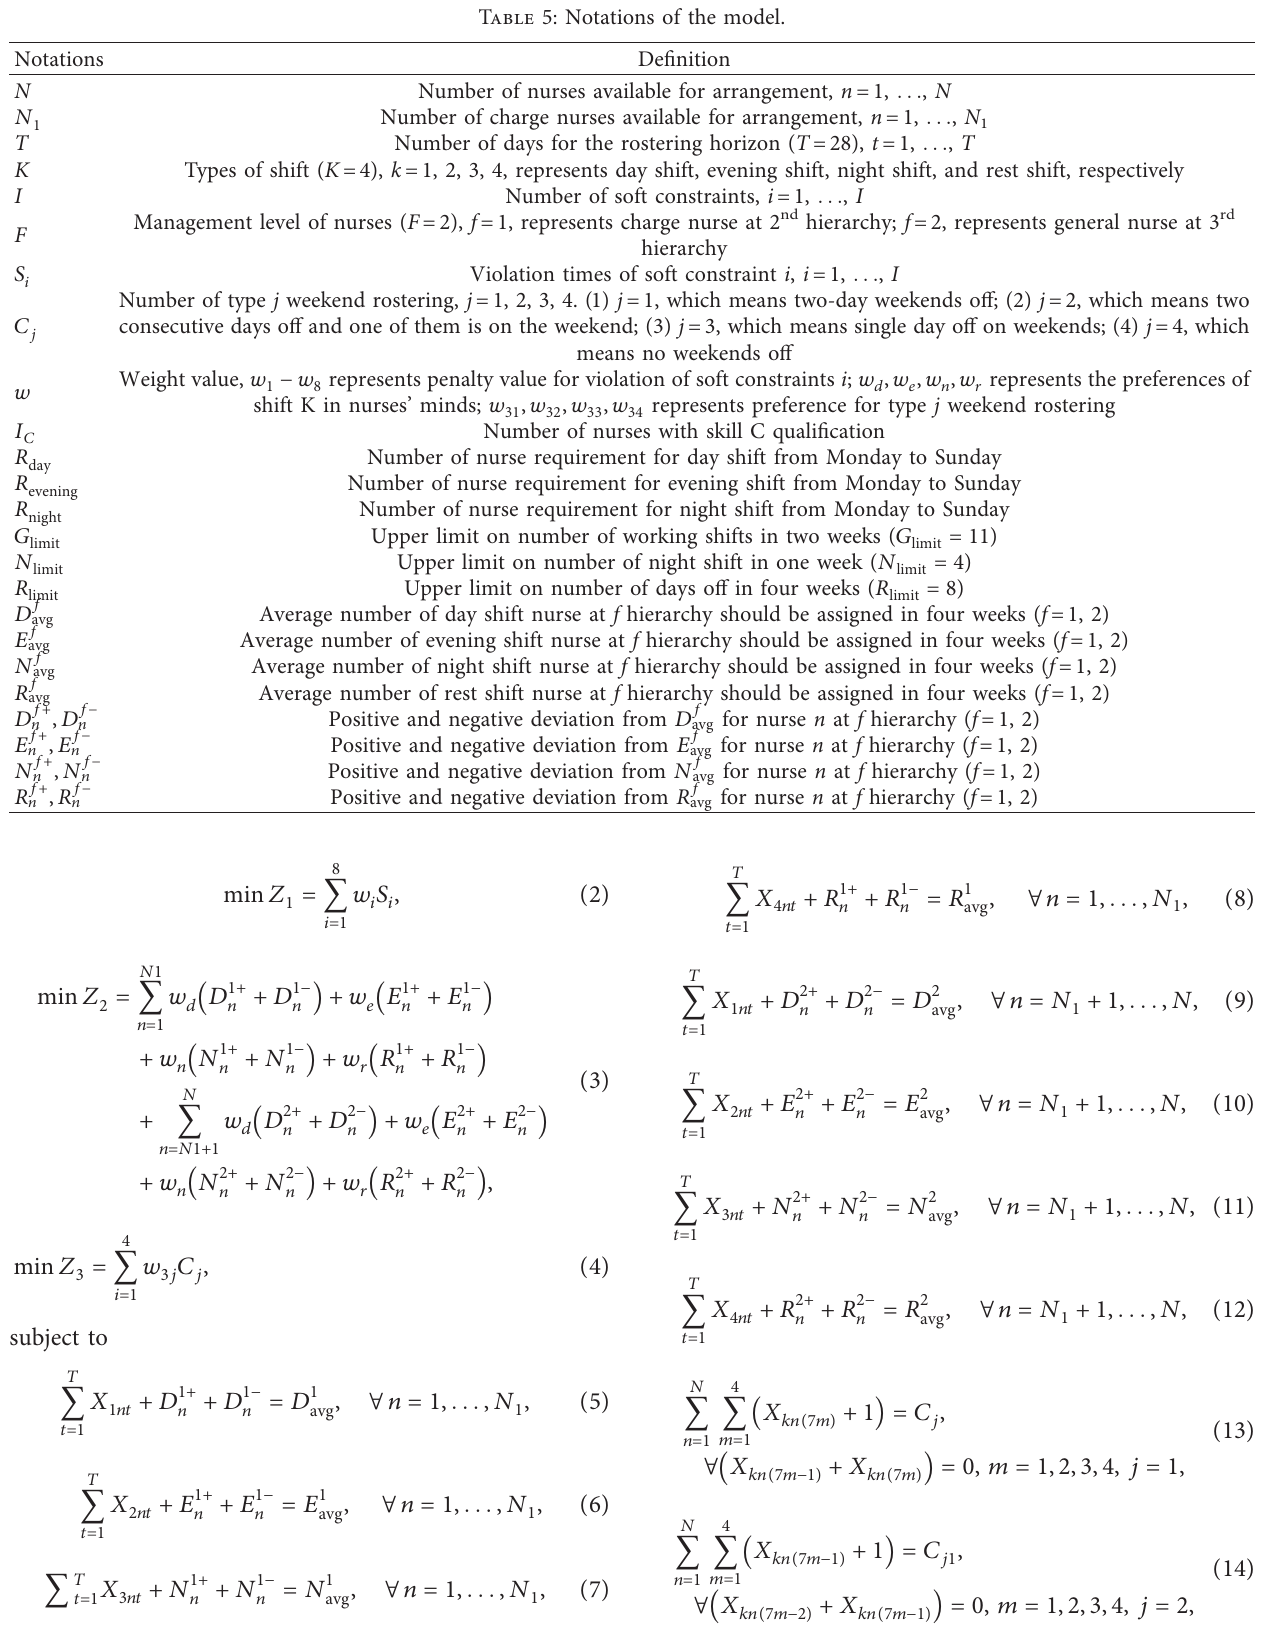
Table 5: Notations of the